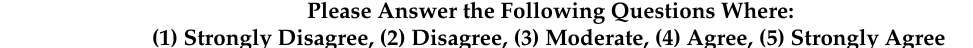
Table 2. Students’ feedback—questionnaire part